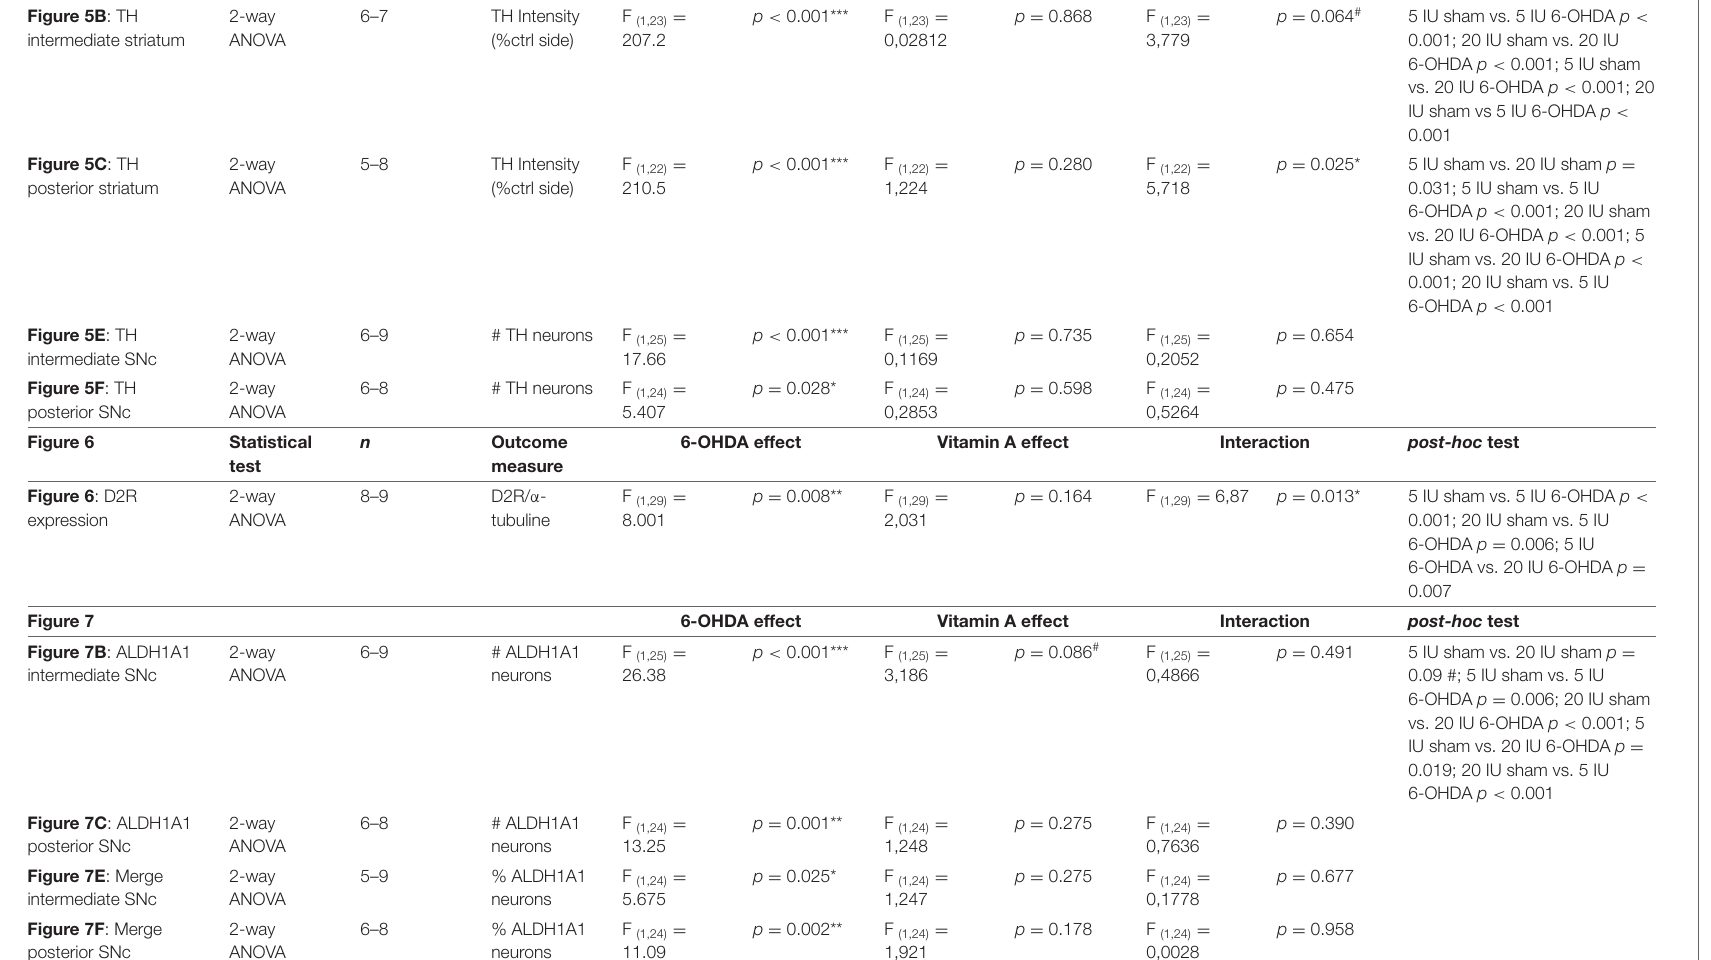
Figure 7C : ALDH1A1 posterior SNc Figure 7E : Merge intermediate SNc Figure 7F : Merge posterior